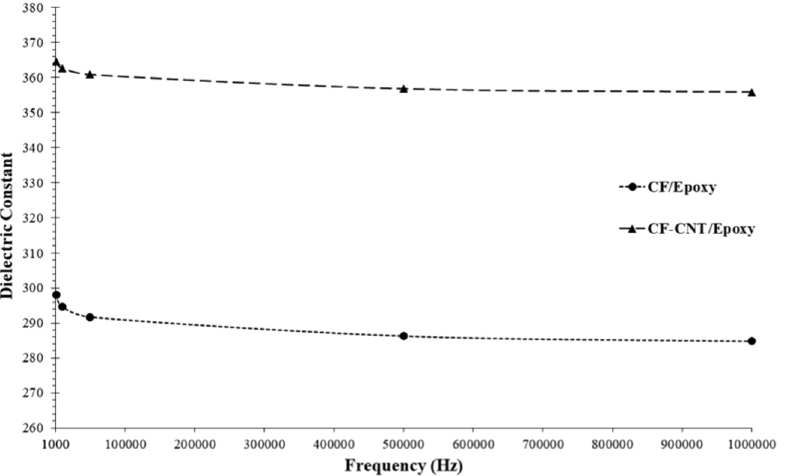
Figure 11: Frequency dependence of the dielectric constants of CF/epoxy and CF –